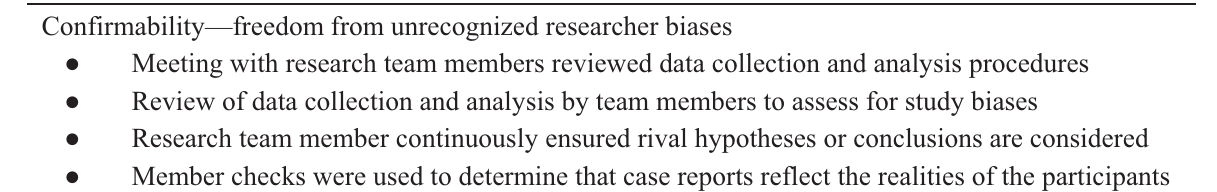
Table 3. Strategies for assuring rigor of the case study